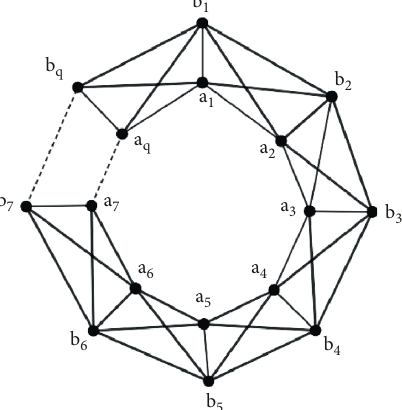
Figure 2: Circular diagonal ladder [ CDL ] Table 3: RN sets and the elements of [ CDL ] Order of each RN set of [ CDL ] q